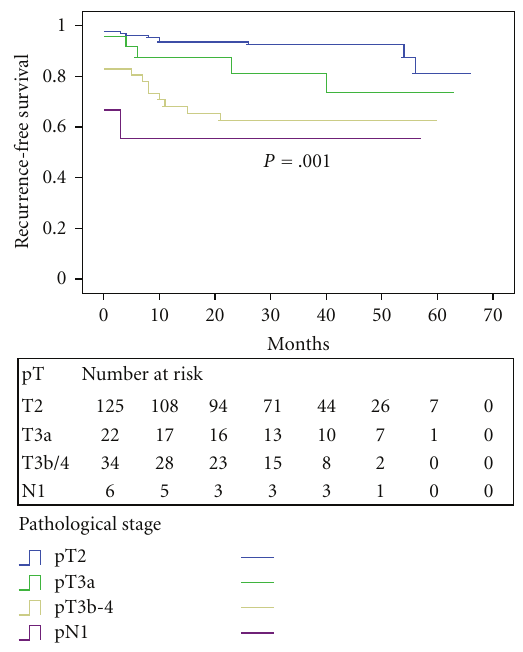
Figure 3: PSA recurrence-free survival stratified by pathological stage.